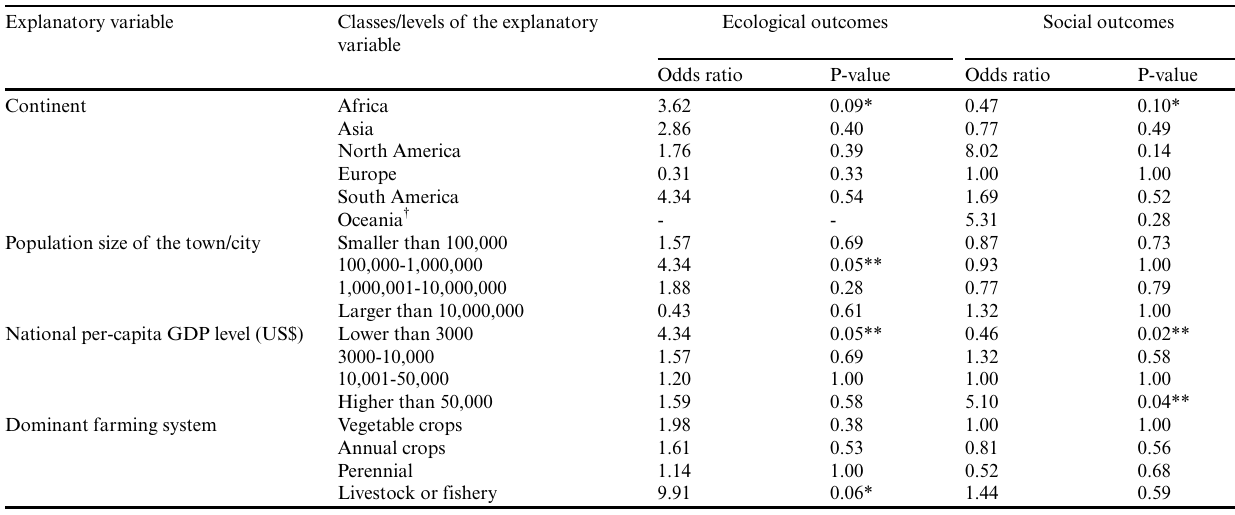
Table 5 . The results of Fisher’s exact tests for the distribution outcomes of urbanization among explanatory variables excluding non- conclusive outcomes. The odds ratio is the likelihood of getting negative outcomes compared to the positive outcomes. ** Outcomes are statistically significant at p < or = 0.05; * Outcomes are statistically significant at p < or = 0.1; † Fisher test is not reported for ecological outcomes because of too small sample size (n = 1)